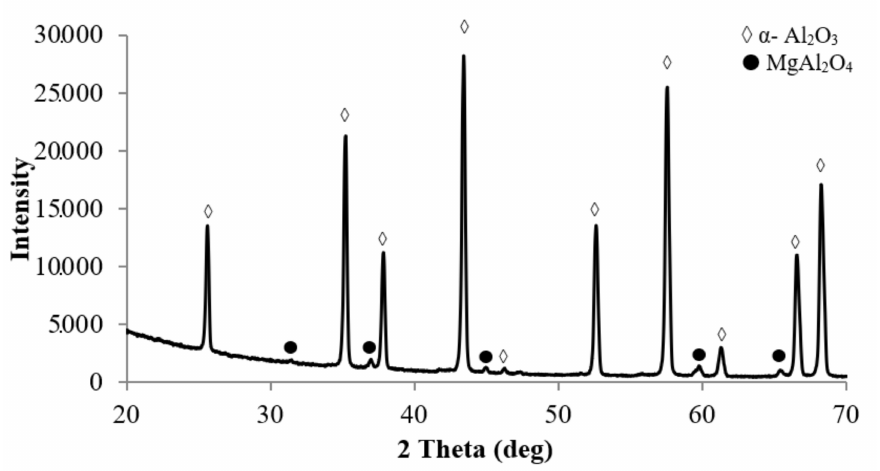
Figure 5. XRD patterns of the α -Al 2 O 3 + 0.5%vol. MgO